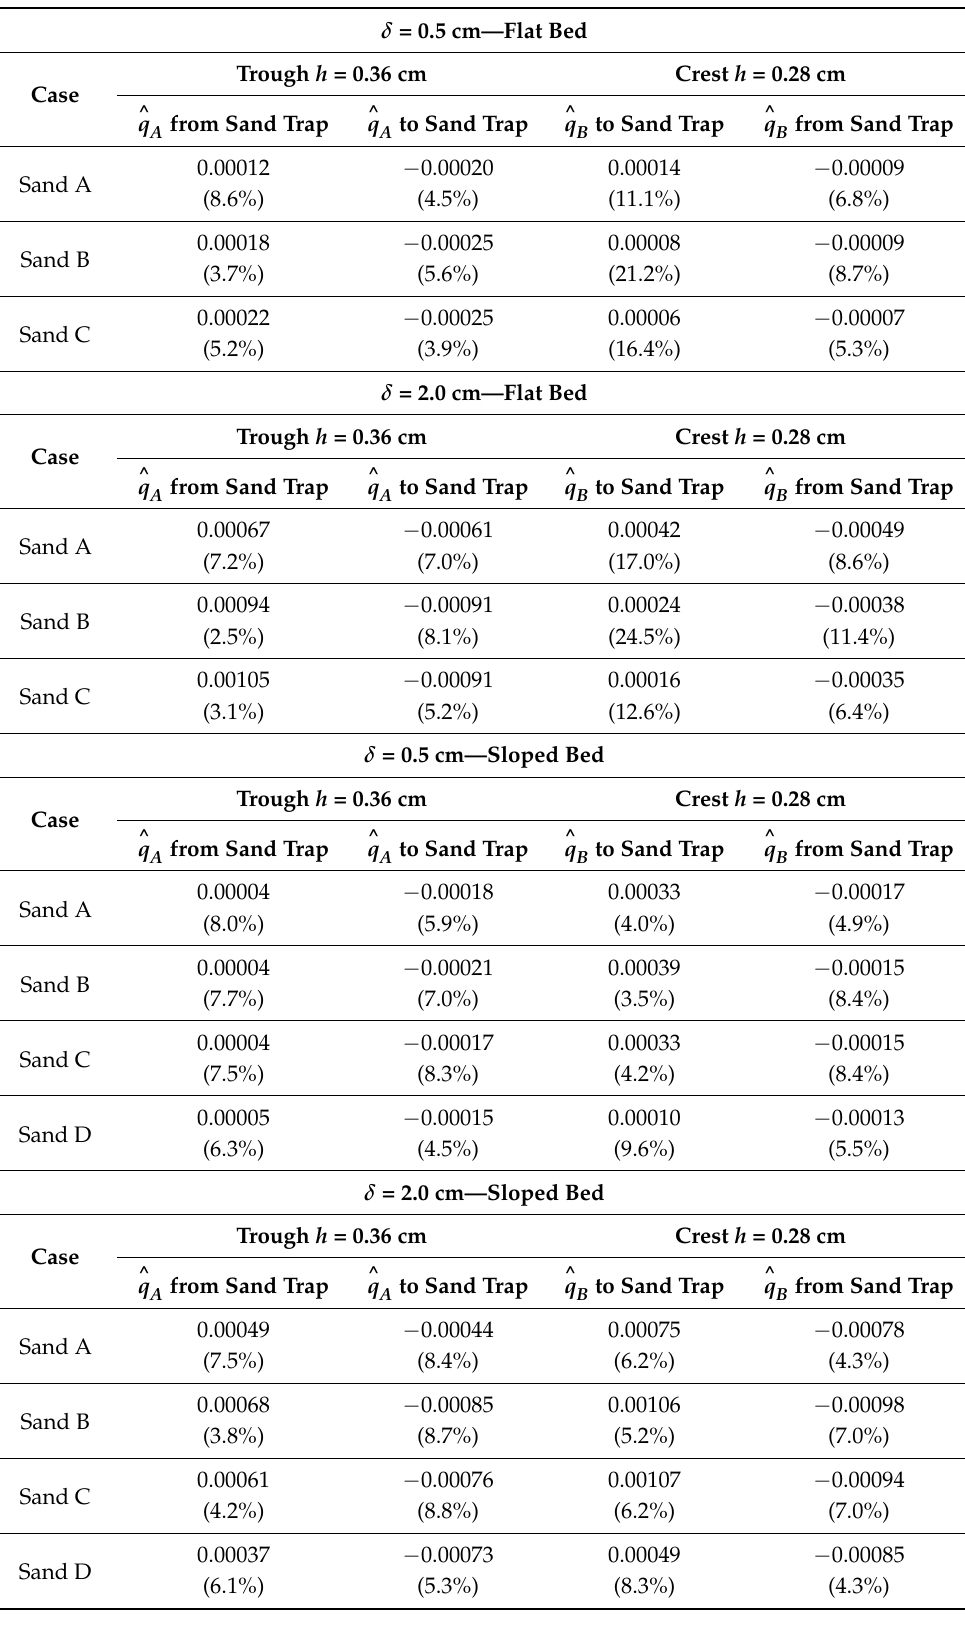
Table 4. The comparison of the wave-average values of the phase-averaged fluxes ˆ q ( A / B ) in the flat bed conditions with the results in the sloped bed